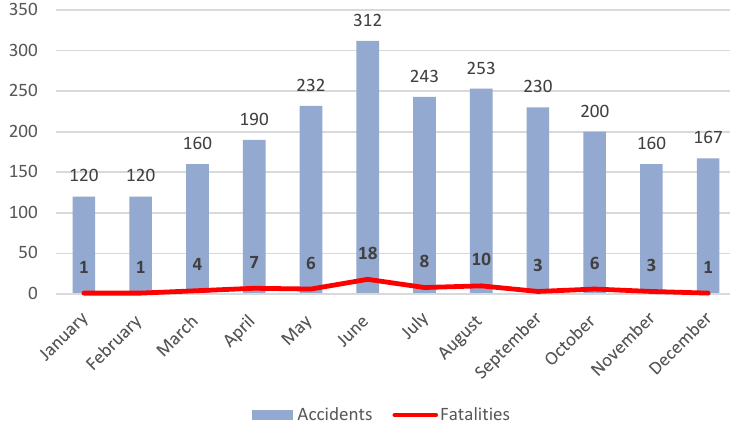
Figure 2. Road accidents involving children aged 0–14 in 2019 in Poland.